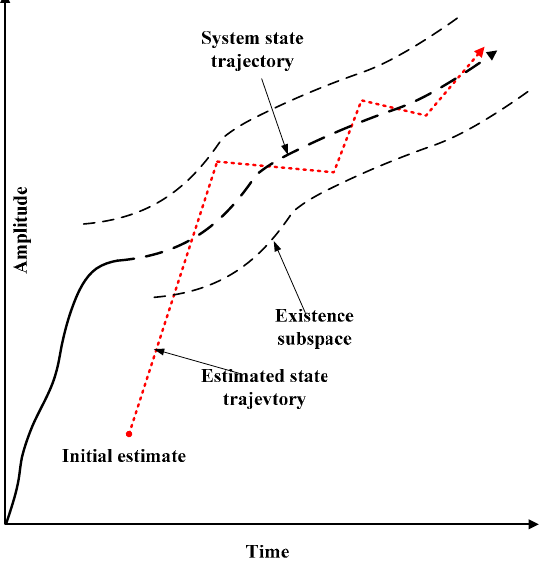
Figure 1. SVSF estimation concept [32] .